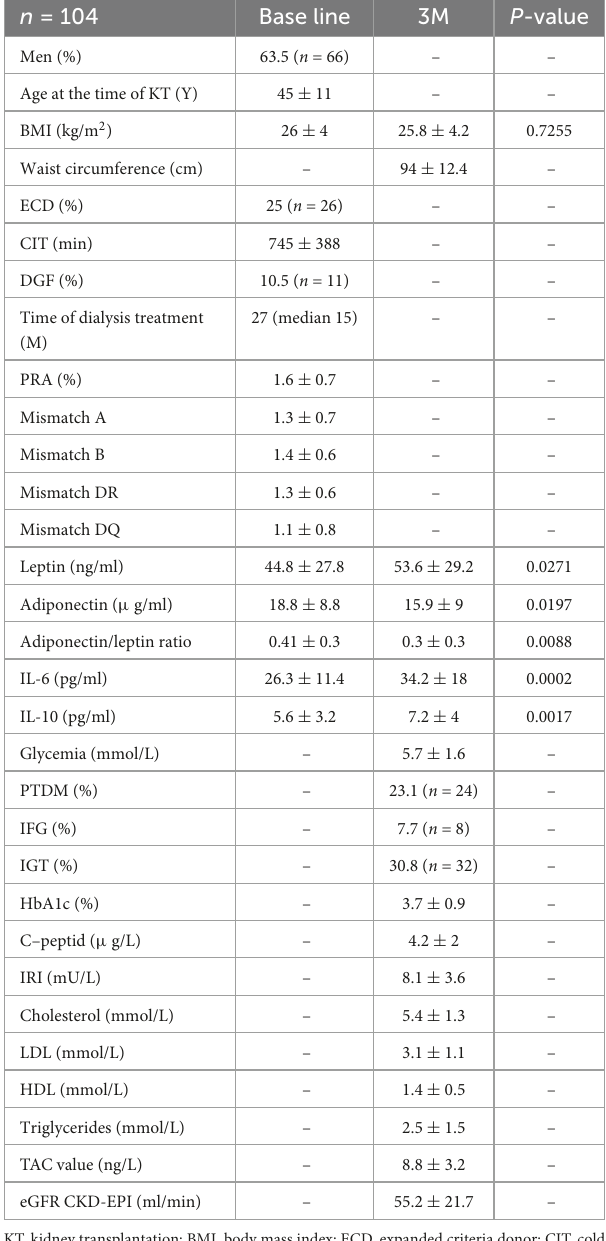
TABLE 1 Basic study file